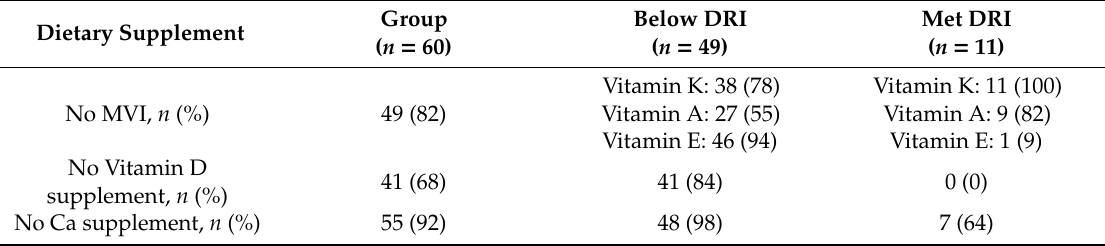
Table 5. Reported Table 5. Reported supplementation.